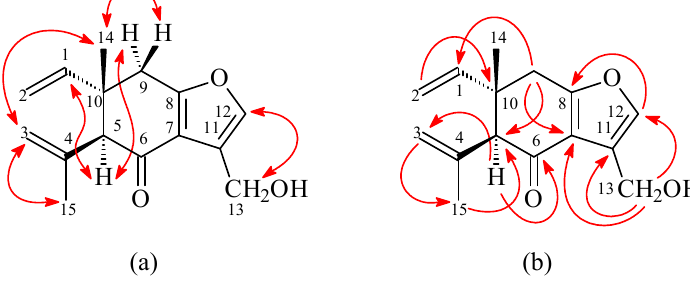
Figure 3. Key ( a ) NOESY and ( b ) HMBC correlations of 1 .